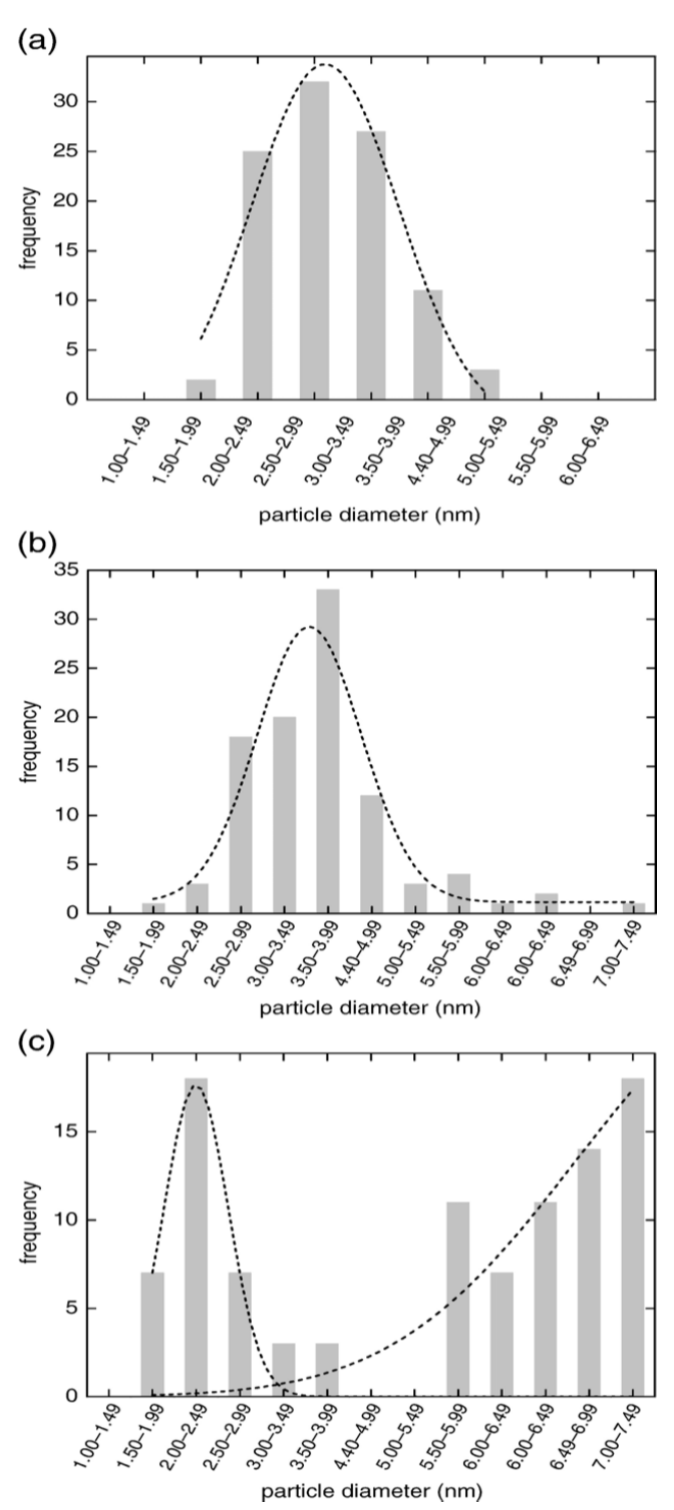
Figure 10. Size histograms for particles made with a 2:1 thiol-gold ratio at ( a ) 800 µL min − 1